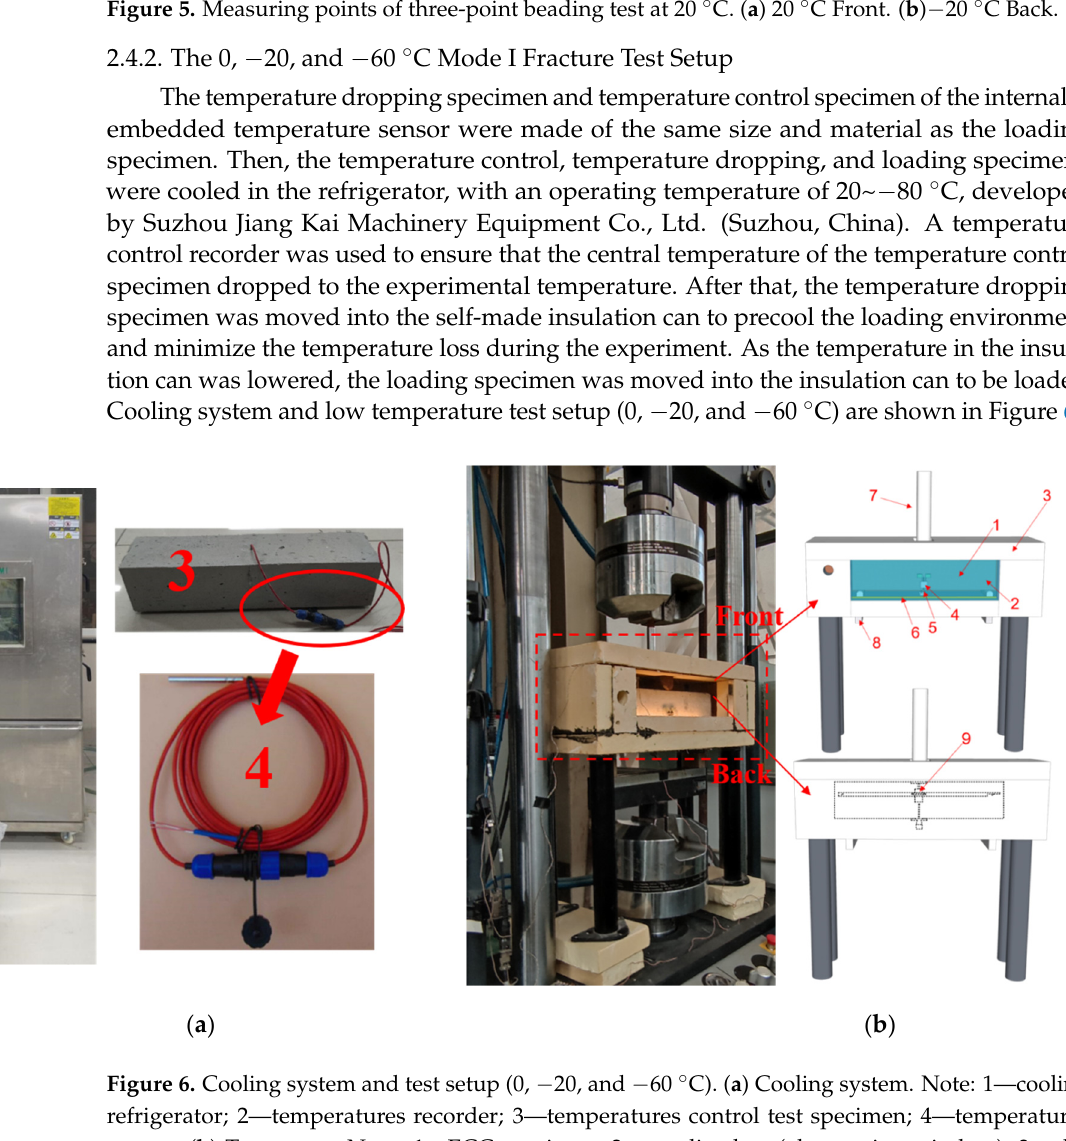
Figure 5. Measuring points of three-point beading test at 20 °C. ( a ) 20 °C Front. ( b ) − 20 °C Back. Two strain gauges were symmetrically pasted at the left and right sides of the front of the initial notch, and each strain gauge had a horizontal distance 5 mm away from the crack tip. Each measuring point data was recorded by a half-bridge, consisting of a work- detected to determine the cracking load [33].